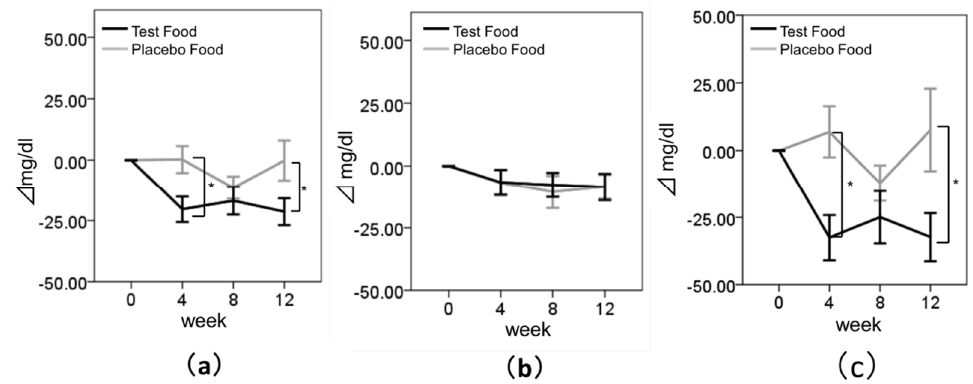
Figure 3. Changes in the levels of TG. Values are means ± SE. ( a ) TG in all subjects; ( b ) TG in subjects whose baseline TG was <100 mg/dL; ( c ) TG in subjects whose baseline TG was ≥ 100 mg/dL. Black bar, test group; Gray bar, placebo group. * Statistically significant, p < 0.05.